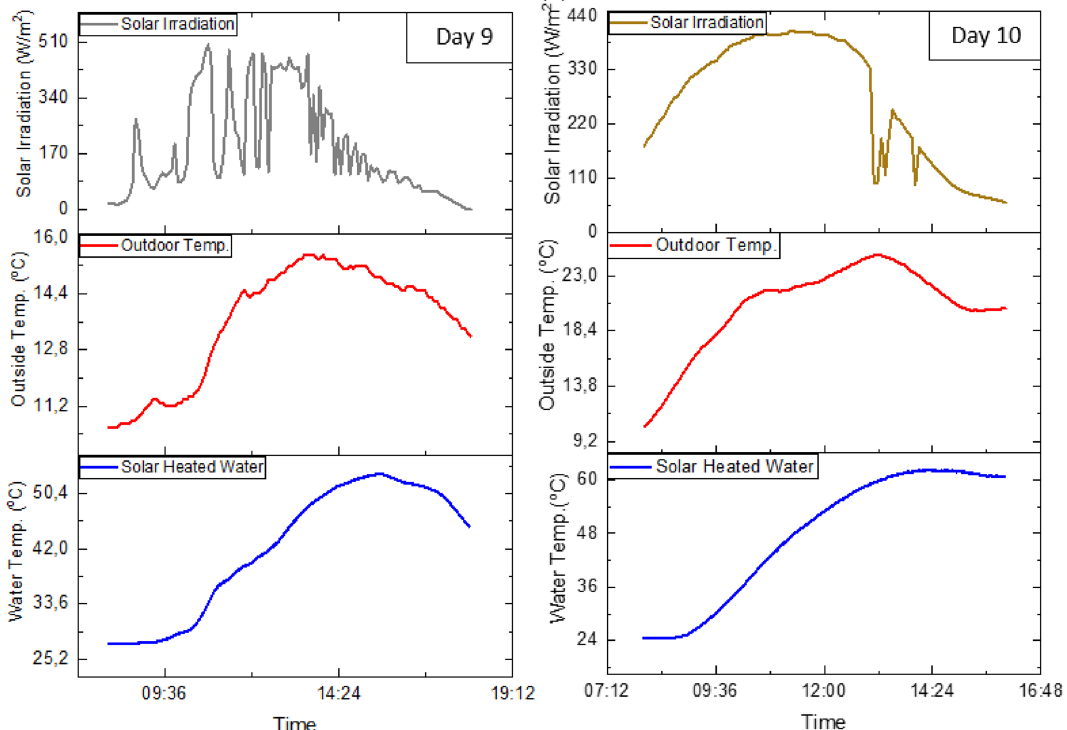
Fig. 8 Solar irradiation, outdoor temperature and solar heated water temperature for day 9 and day